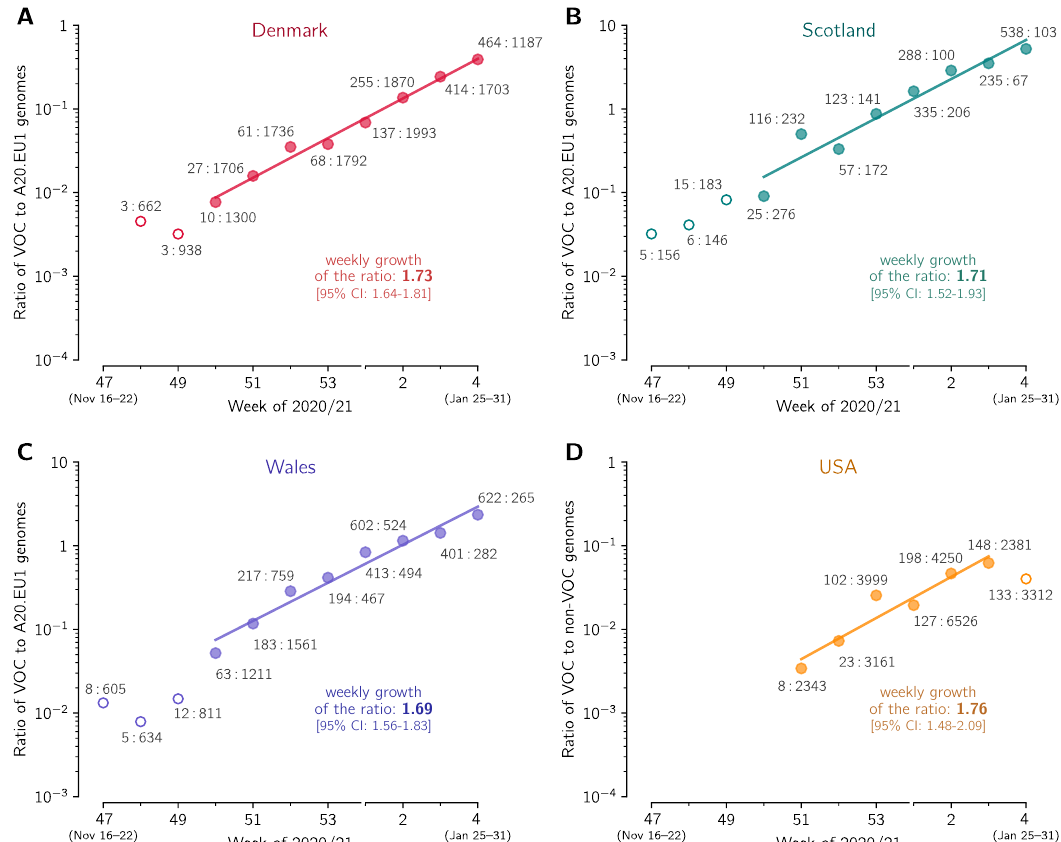
Figure 3. The replicative advantage of the VOC in (A) Denmark, (B) Scotland, (C) Wales, and (D) USA. ( A ) The ratio of the VOC to the 20A.EU1 sequences collected in Denmark. The trend line is fitted to data points from week 50 of 2020 to week 4 of 2021. ( B ) The ratio of the VOC to 20A.EU1 sequences collected in Scotland. The trend line is fitted to data points from weeks 50 of 2020 to week 4 of 2021. ( C ) The ratio of the VOC to 20A.EU1 sequences collected in Wales. The trend line is fitted to data points from week 50 of 2020 to week 4 of 2021. ( D ) The ratio of the VOC to non-VOC sequences collected in USA. The trend line is fitted to data points from week 51 of 2020 to week 3 of 2021. Data points are labeled with ratios of the counts of genome sequences. The weekly growth rates and respective confidence intervals are given in each panel. All panels are based on GISAID data submitted till 17 February 2021 (provided in Supplementary Data File S1).